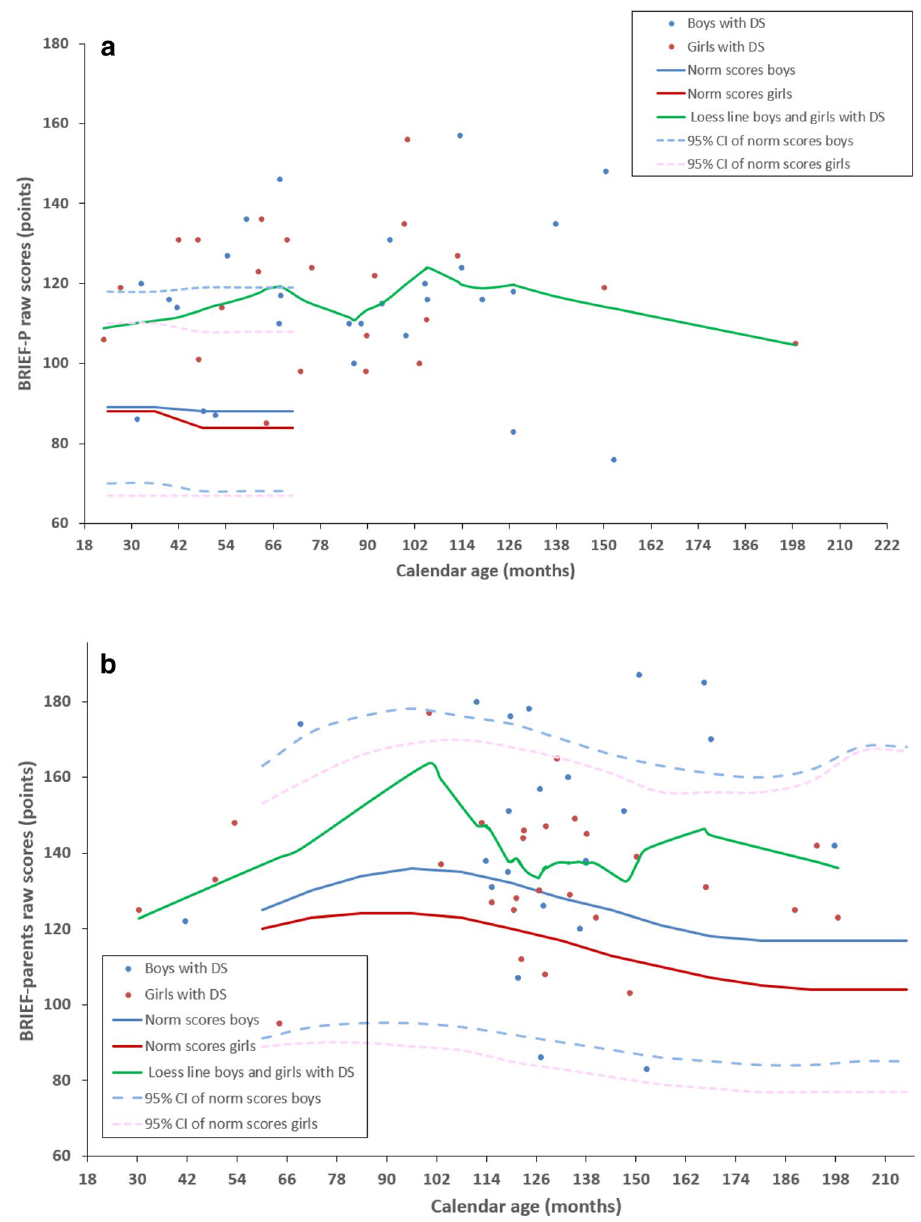
Figure 3. Informant rated executive functions. ( a ) BRIEF-P results for children with DS younger than 8 years (n = 49) Normative data (n = 1747, age 2–5 years) from Gioia et al. 17,18 . b ) Parent’s version of the BRIEF for children of 8 years and older with DS (n = 89). Normative data (n = 3333, age 5–17 years) from Huizinga et al. 20,21 . c ) Teacher’s version of the BRIEF for children of 8 years and older with DS (n = 39). Normative data (n = 941, age 5–11 years) from Huizinga et al. 20,21 . Data of children with DS are typically above the norm indicating that children with DS scored poorer on this executive functions scale. Blue bullets: Measured boys with DS (BRIEF-P n = 27, BRIEF parents’ version n = 22, teachers’ version n = 18). Red bullets: Measured girls with DS (BRIEF-P n = 22, BRIEF parents’ version n = 28, teachers’ version n = 21). Green curve: Loess line fitted to the data from ratings on children with DS pooled across boys and girls. Blue curve: Norm scores (mean) of typically developing boys. Red curve: Norm scores (mean) of typically developing girls. Light blue dashed lines: upper and lower bound of the 95% confidence interval of norm scores of typically developing boys. Pink dashed lines: upper and lower bound of the 95% confidence interval of norm scores of typically developing